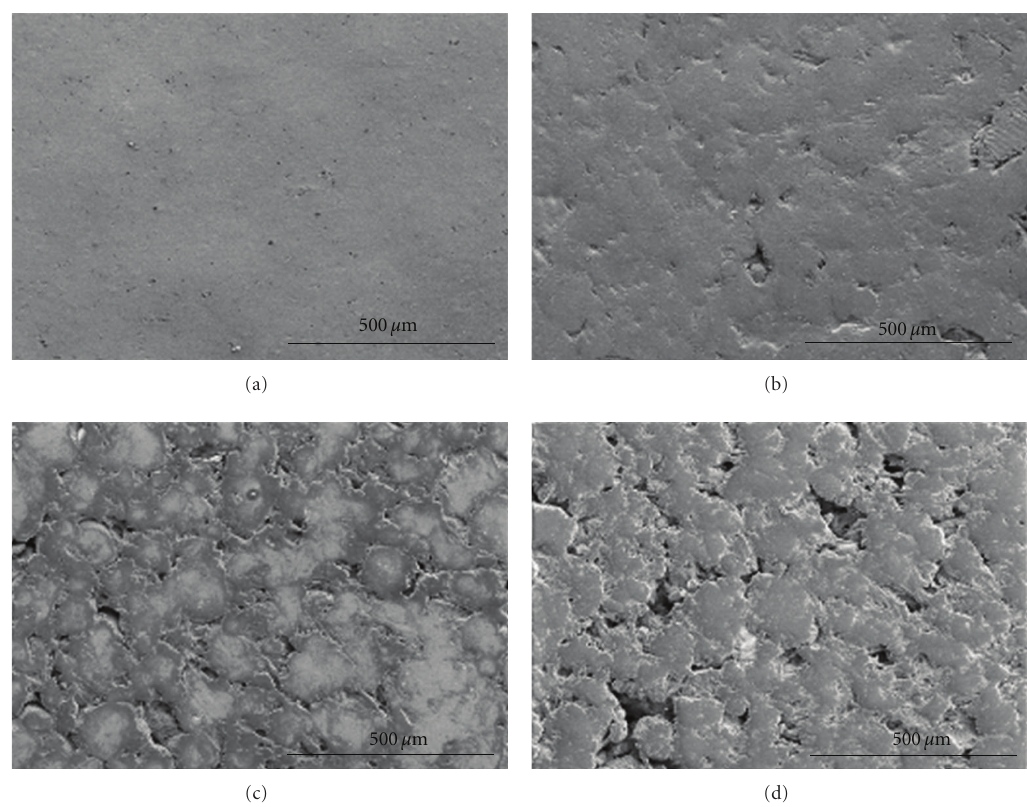
Figure 1: SEM images showing the surfaces of the WG layer with 20wt.% of plasticizer containing glycerol and oleic acid in the mass proportions: (a) 100: 0, (b) 75 :25, (c) 50:50, and (d)